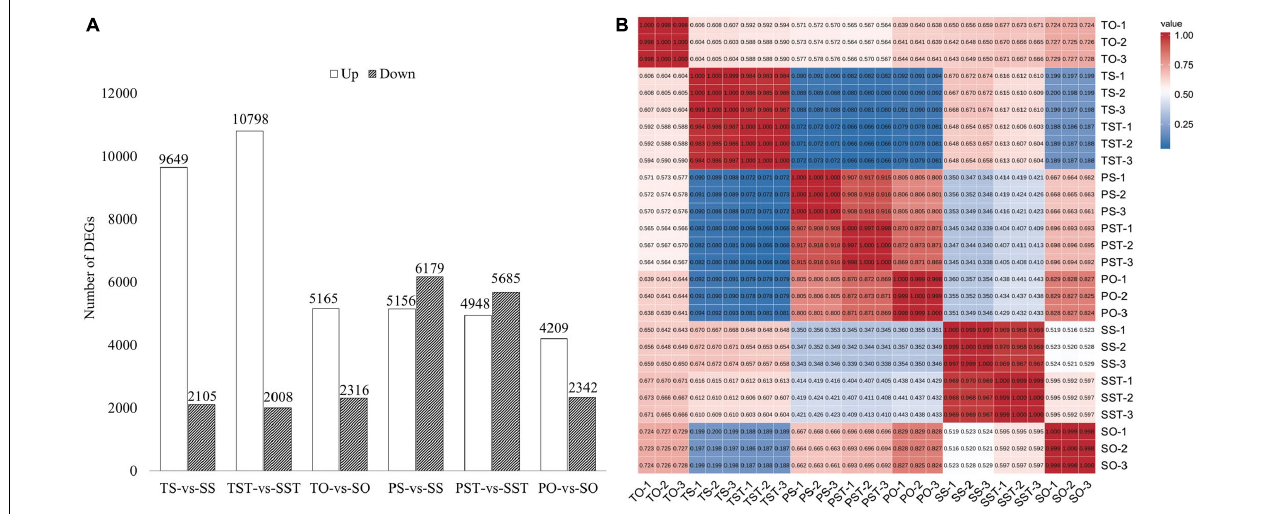
FIGURE 3 | Analysis of DEGs. (A) The statistics of DEGs between groups. T, Tenera; P, Pisifera; S, Seedless; S, stigma; ST, style; O, ovary. (B) Heatmap of pairwise correlations between samples based on gene expression. Color bars represent the values of Pearson correlation.